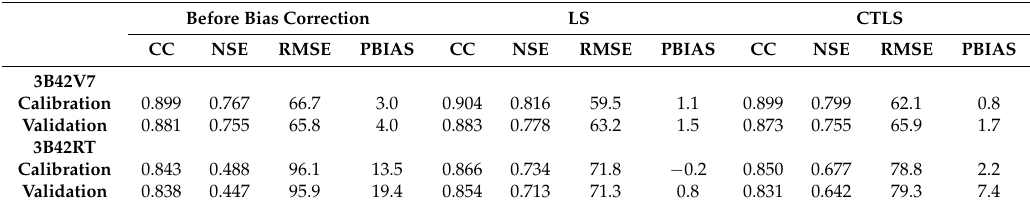
Table 10. The average performance of calibration and validation for CTLS with TMPA 34B42V7 and TMPA 3B42RT on a monthly scale. Before Bias Correction